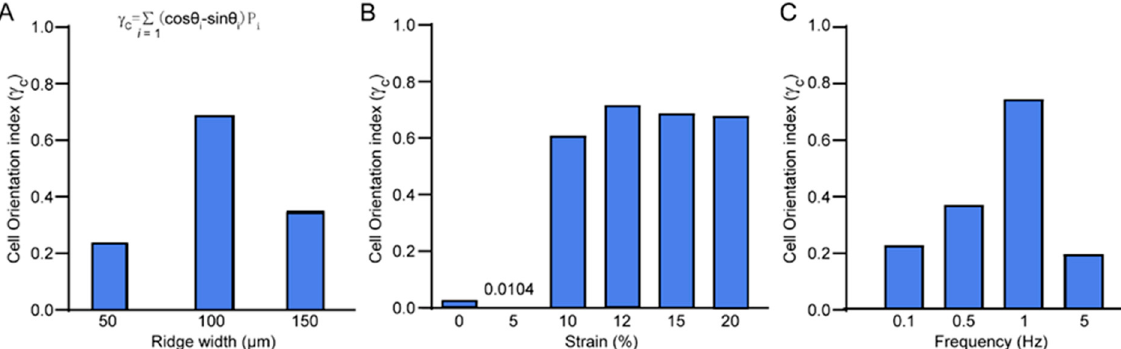
Figure 6. Cell orientation index showing the relationship between the cell arrangement and ridge width ( A ), strain ( B ), and stretching frequency ( C ). When the index is near 0, the cells are oriented randomly. When the index is near 1, the cells are parallel to the lateral direction. If the index is near − 1, the cells are orientated in the longitudinal direction.